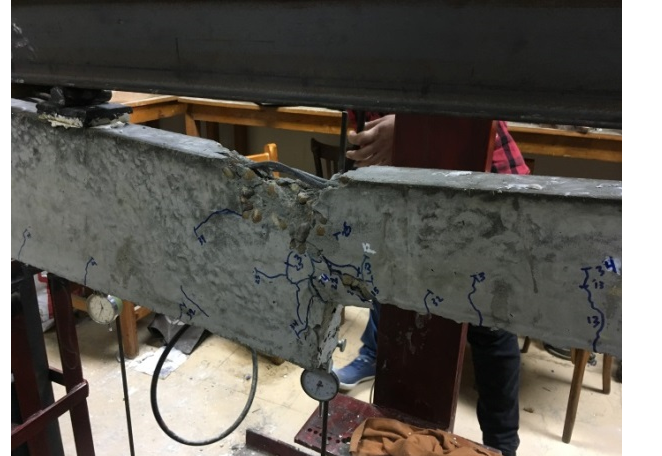
Figure 13. Crack pattern of beam B3.